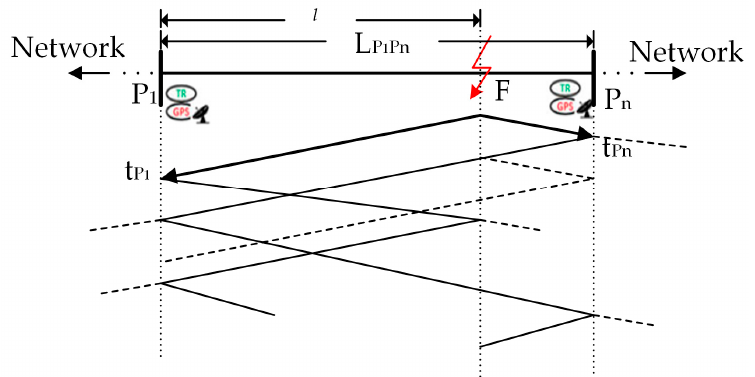
Figure 2. Propagation of fault-induced traveling waves.